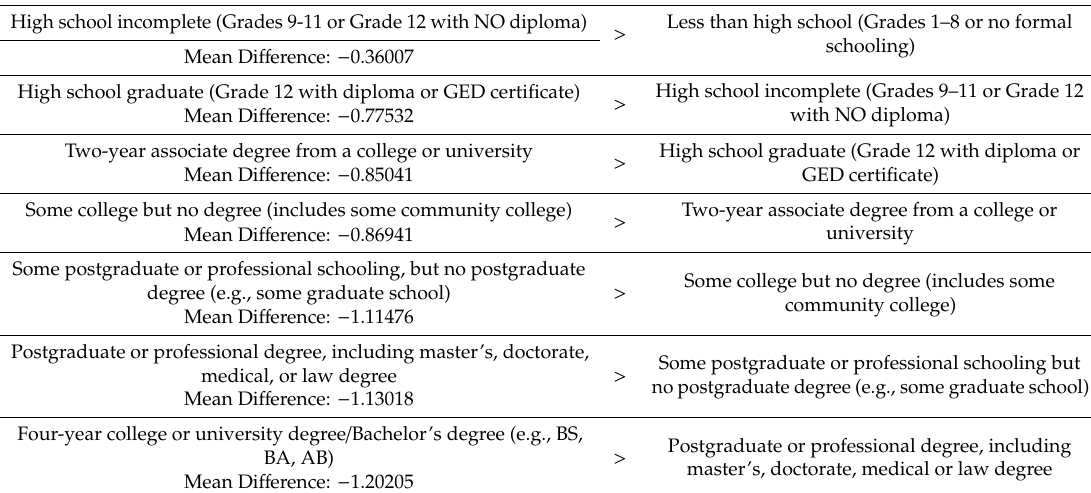
Table 1. ANOVA—Results of the Bonferroni post hoc test (Relationship between social media use and level of education. The answers “Don’t know” and “Refused” are not shown, and the mean di ff erence for “Less than high school” comes from our own